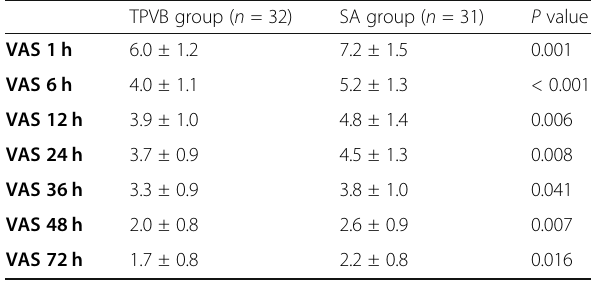
Table 2 Pain score on visual analogue scale at rest Table 3 Pain score on visual analogue scale on